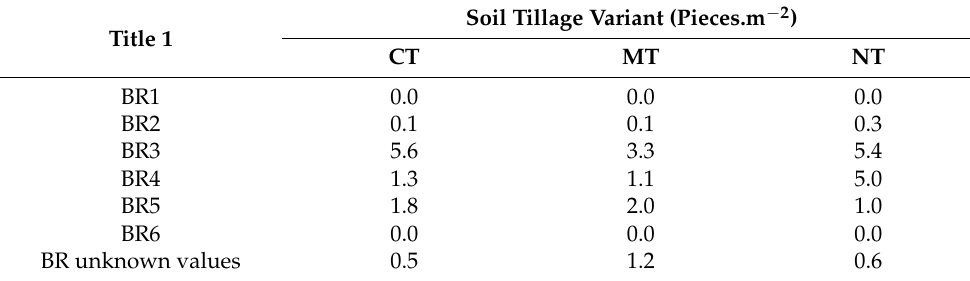
Table 3. Groups of weeds according to the biological relevance of tillage variants.